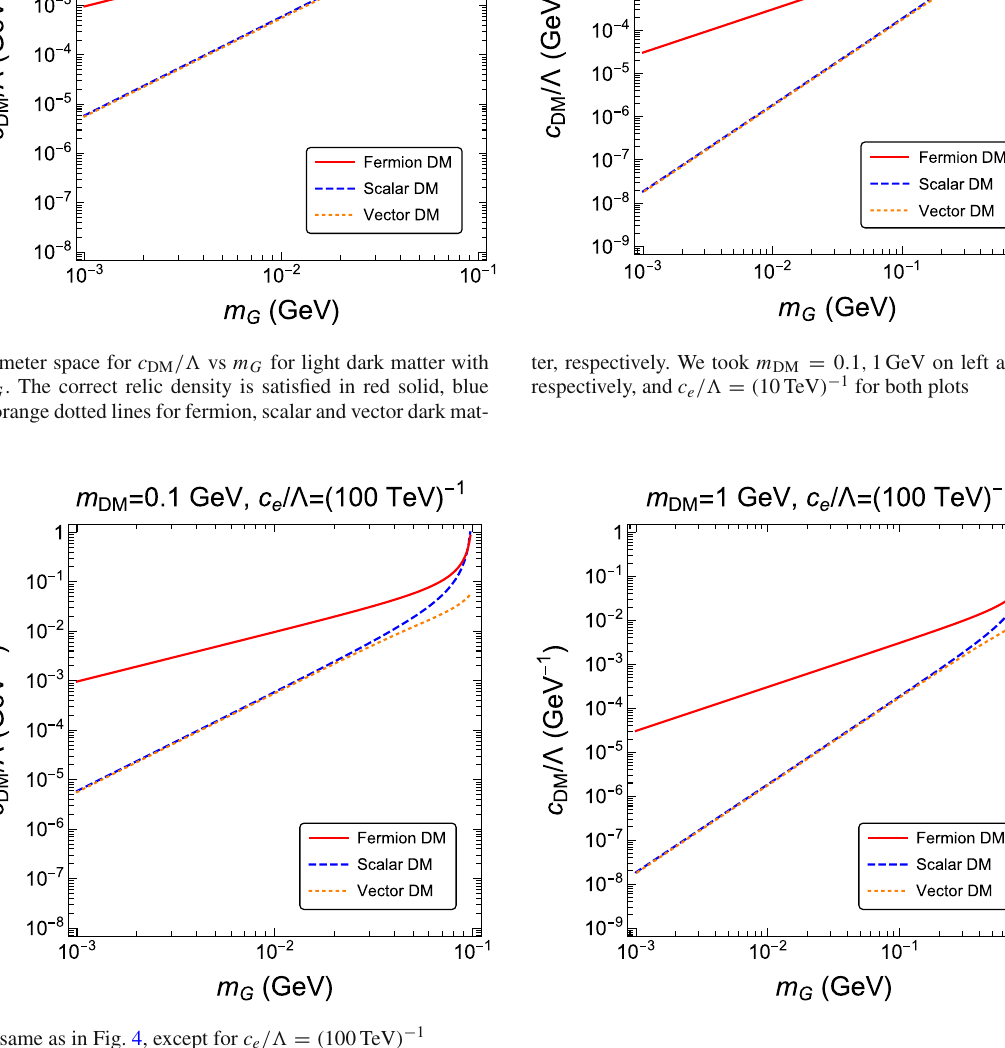
Fig. 5 The same as in Fig. 4, except for c e /(cid:3) = ( 100TeV ) −